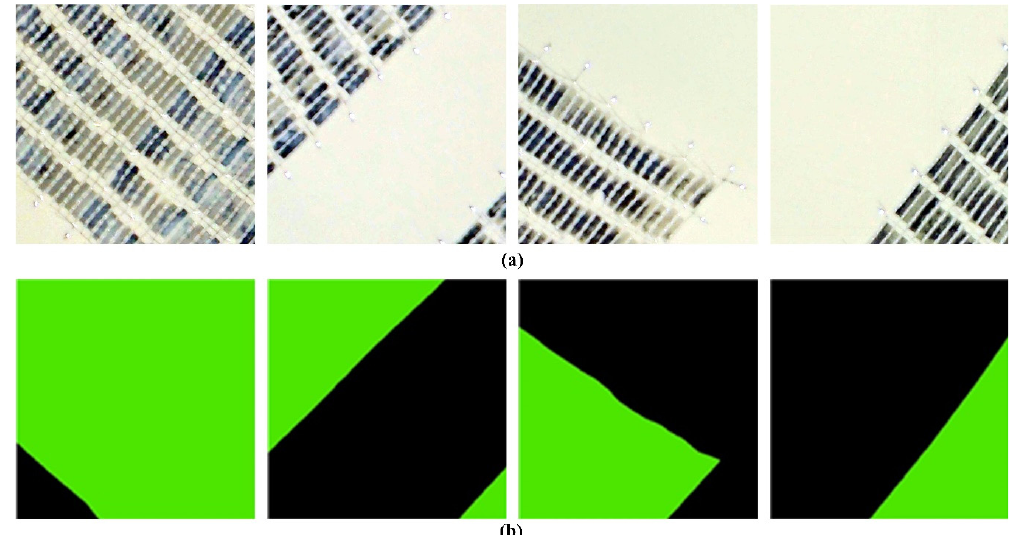
Figure 5. Part of the training dataset used for model training. ( a ) The train images; ( b ) The ground truth maps. Table 1. Environmental configuration. Table 1. Environmental configuration.